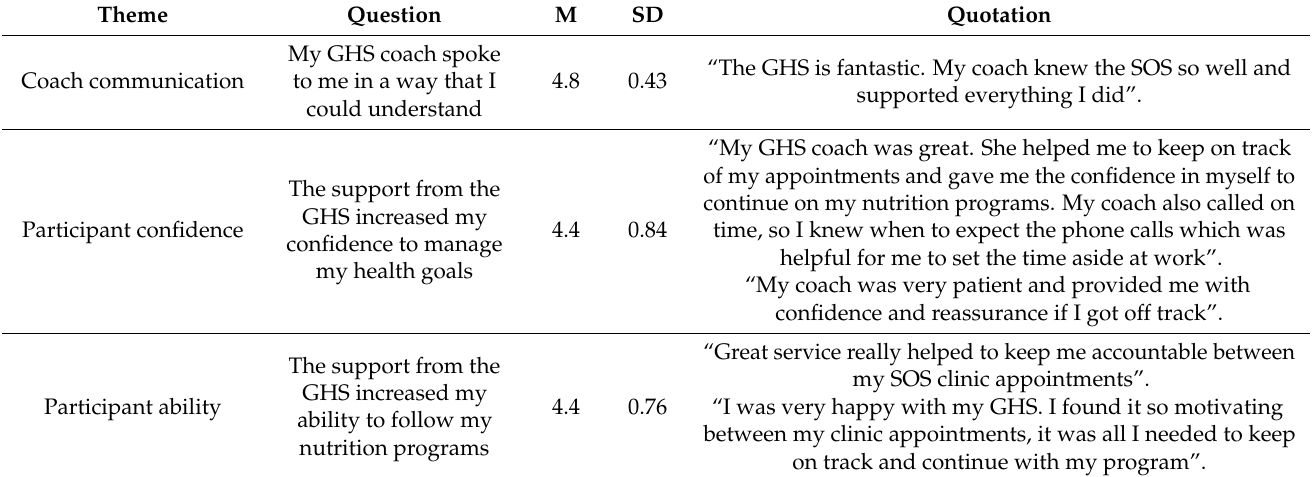
Table 3. Qualitative data from participant